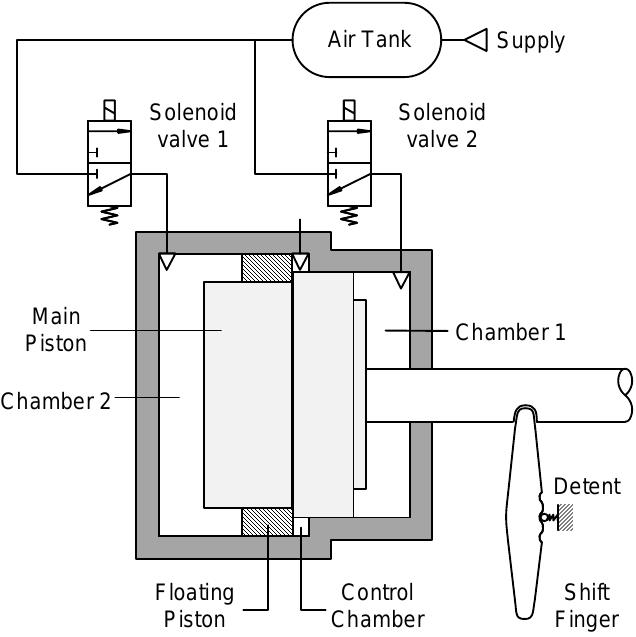
Figure 1. Simplified layout of the gearbox